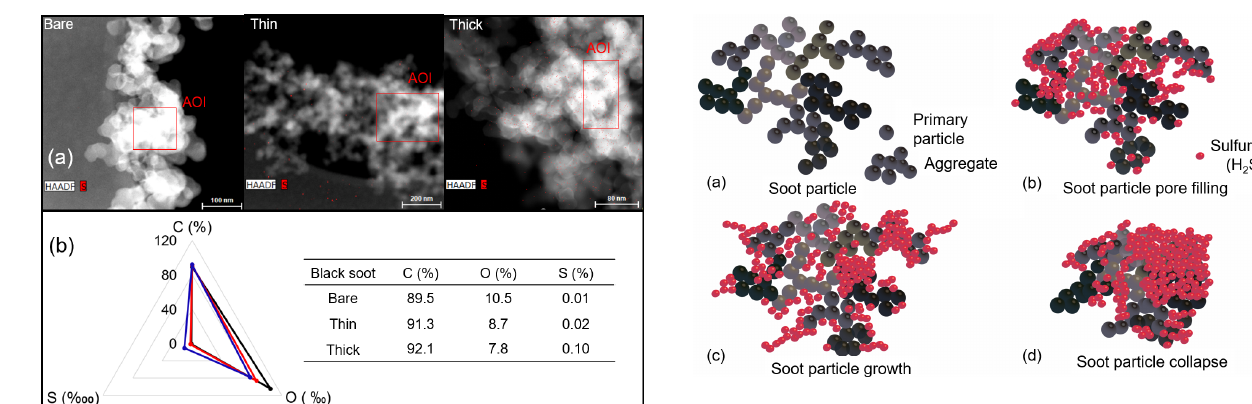
Figure 12. Illustration of the proposed H 2 SO 4 coating processes for soot particles (not to scale). Bare soot particle (a) and soot parti- cle pore filling and surface coating induced by progressive increase in H 2 SO 4 coating mass (b, c, d)